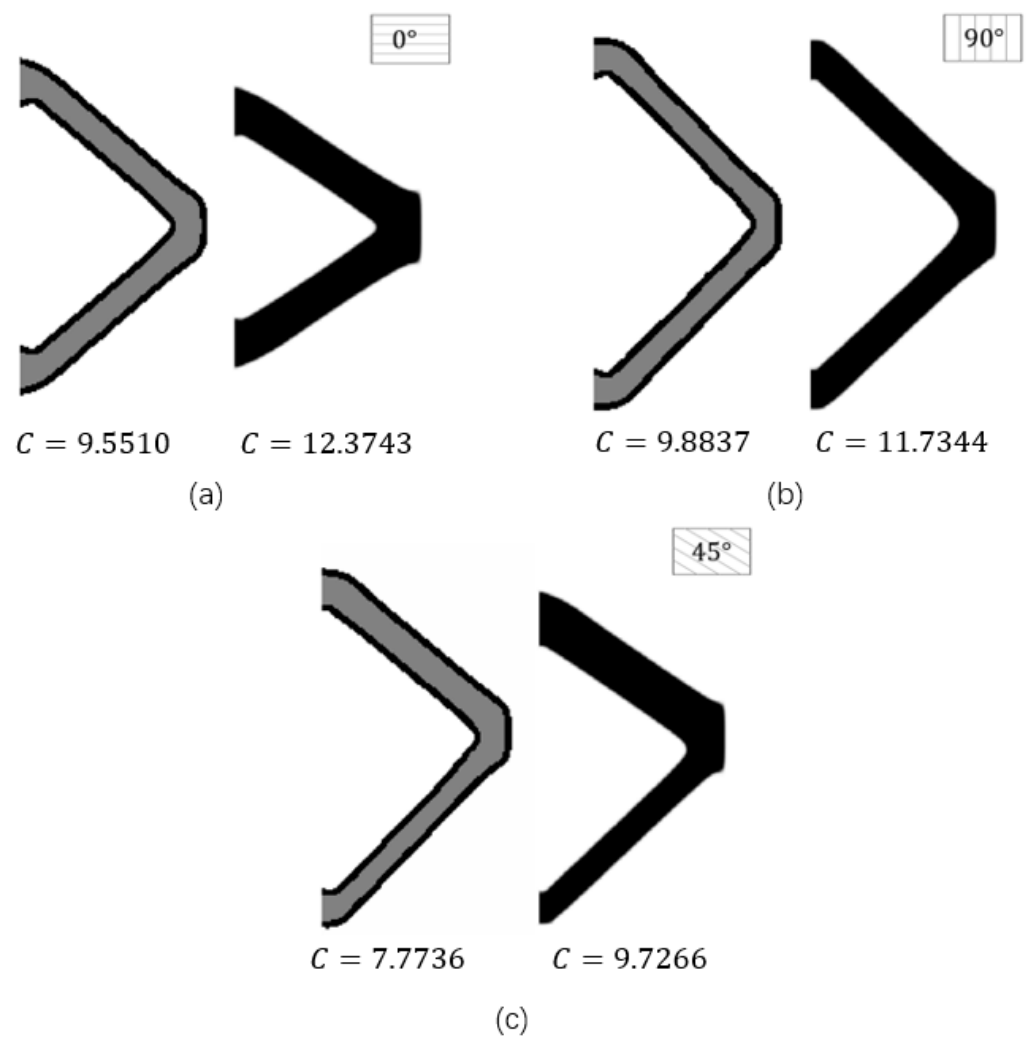
ff erent raster directions: ( a ) θ = 0 ◦ ; ( b ) θ = 90 ◦ ; ( c ) θ = 45 ◦ Figure 18. The optimized results with different raster directions: ( a ) 𝜃 = 0° ; ( b ) 𝜃 = 90° ; ( c ) 𝜃 = 45° . Figure 18. The optimized results with di